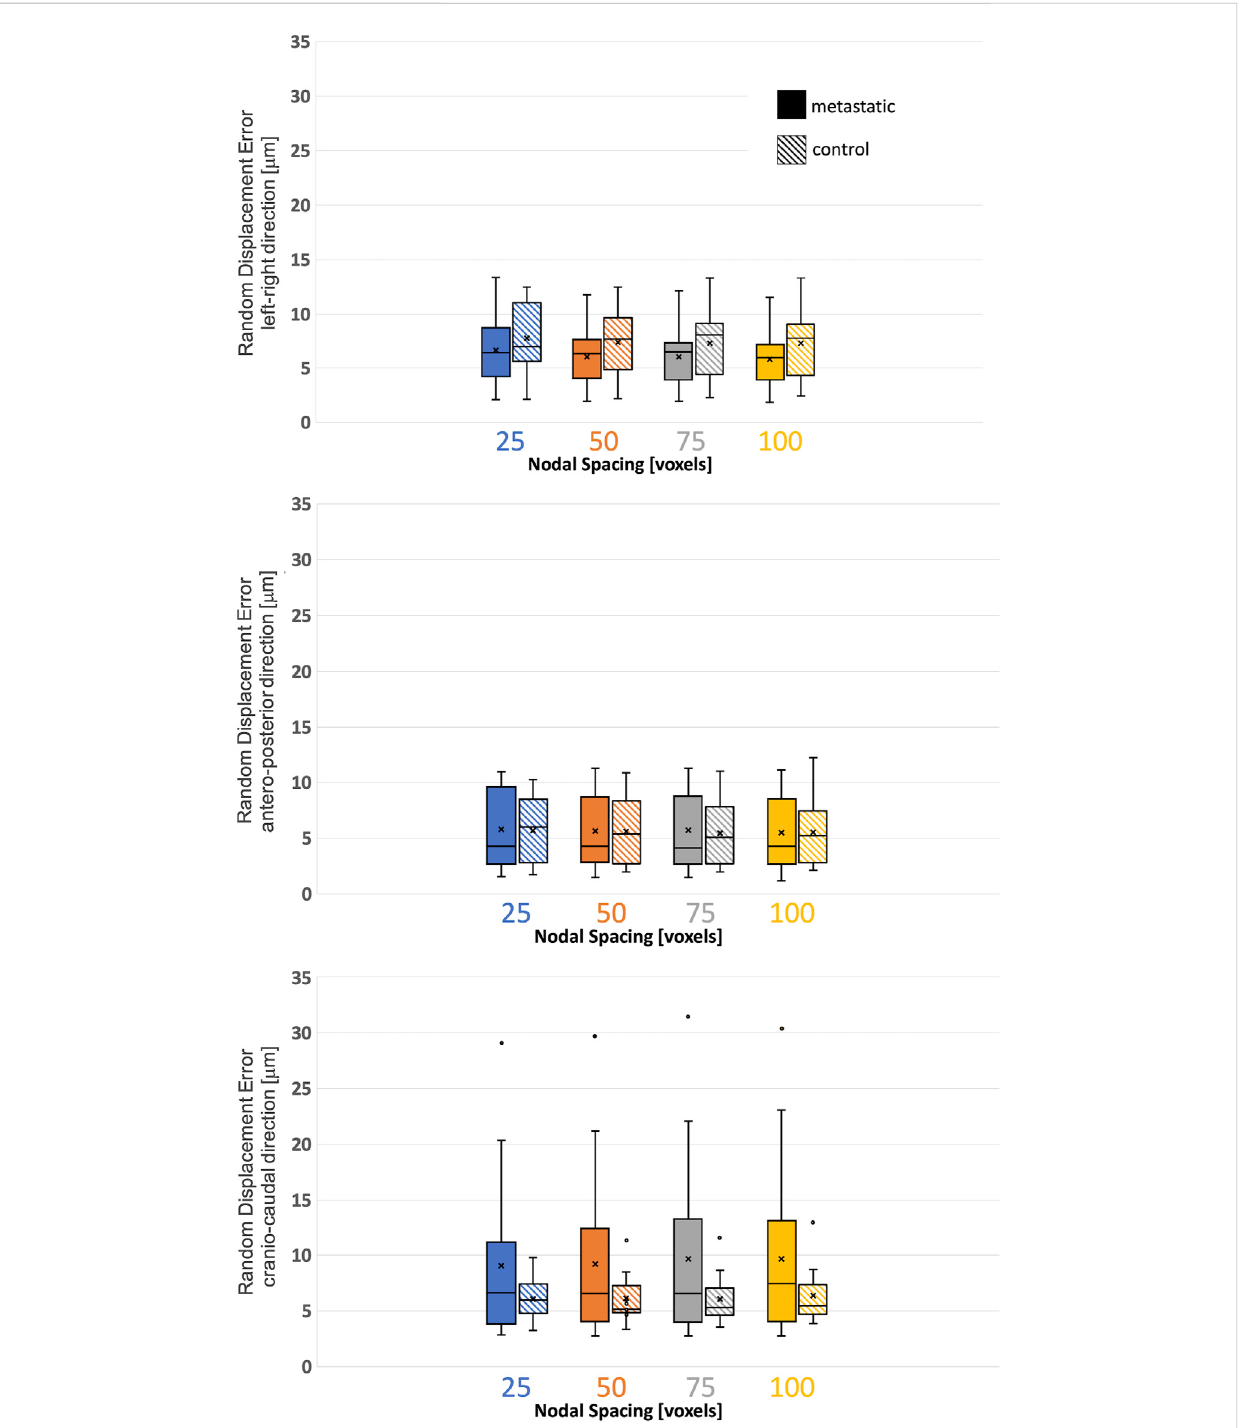
FIGURE 3 Variability ofthedisplacementprecisioninmetastaticand control vertebraeinVOI_DVCfordifferentnodalspacingof25voxels(0.975 mm)inblue, 50 voxels (1.95 mm) in orange, 75 voxels (2.925 mm) in grey, and 100 voxels (3.9 mm) in yellow. The box is limited by the fi rst and the third quartile. Whiskers represent the lowest and highest data point in the data set excluding any outliers (dots). Mean and median values among the group are represented by the cross and the horizontal line,